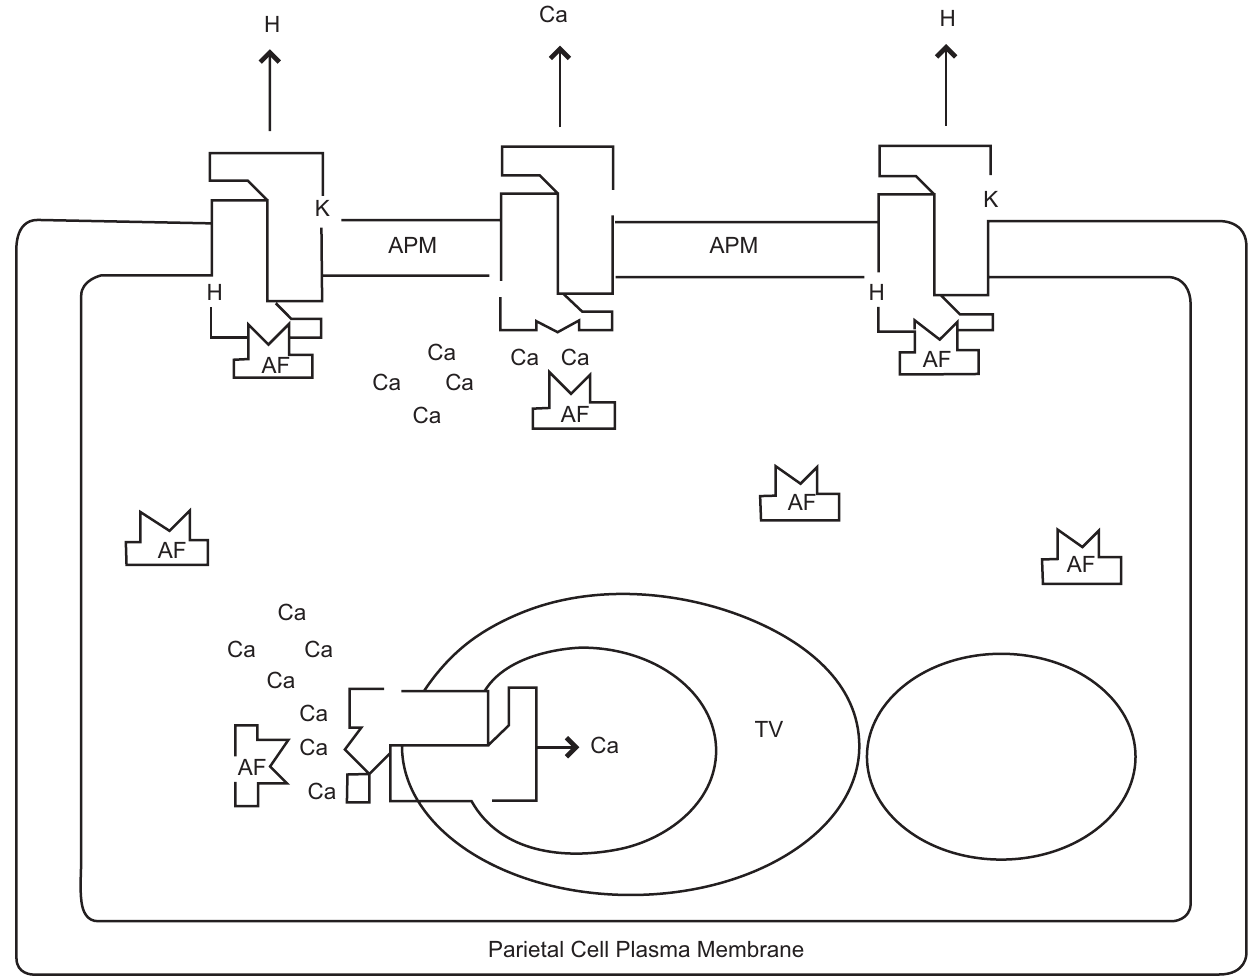
Figure 1. Critical interplay of calcium in the HAF-mediated (displayed as “AF”) regulation of the gastric H, K-ATPase pump showing oscillation between its H- and Ca-transporting modes depending on the local Ca level. In a similar fashion, the H, K-ATPase will also act as a Na-pump (not shown in the diagram) at the basolateral membrane depending on the local Na-concentration and pH. Following our current evidence, the critical interplay among the HAF, H, K-ATPase and Ca in parietal cells is depicted in this diagram. While the pump molecules integral to the tubulovesicle (TV) are stimulated appreciably by the HAF, those associated with the apical plasma membrane (APM) are absolutely dependent on the HAF for their function, revealing the essential nature of the HAF in gastric proton-pump function 17 . For the ATPase assay 9 the desired amount of HAF (as indicated by the prior dose response study) was first pre-incubated with 5 µg of APM for 10 minutes at 37°C in 2 mM Pipes buffer (pH 7.4). The concentration of free Ca was regulated by varying Ca at a fixed concentration of 0.5 mM